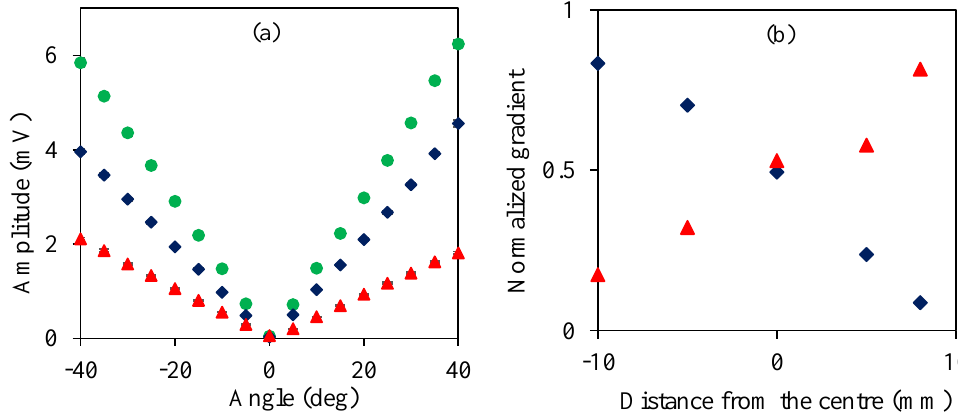
Figure 10. ( a ) Measurement of the angular dependence of the rf signal amplitude with the primary rf field produced by two coils (green points) and a single coil on the same (navy diamonds)/opposite (red triangles) side of the plate with respect to the sensor. Each point represents the mean of 30 measurements and the error bars show the standard deviation. Different gradients of the signal angular dependence result from different lift-offs of the primary rf field coils. ( b ) Normalised dependence of the signal’s angular dependence gradient on the difference in lift-off of the coil on the same (navy diamonds)/ (red triangles) opposite side of the plate. Lift-off is measured from the point at which the two coils lift-off is equal and the distance between the two coils is the same for all